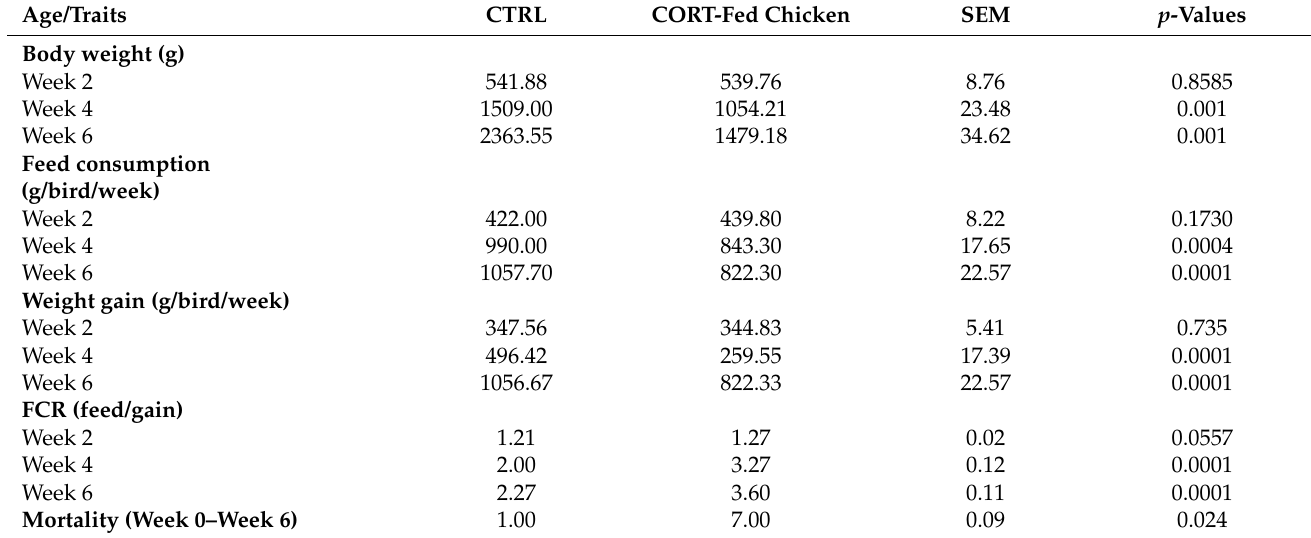
Table 3. Effects of corticosterone administration on body weight, feed consumption and feed conversion ratio (FCR) of broiler